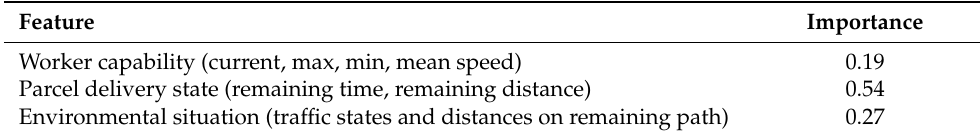
Table 2. Aggregated feature